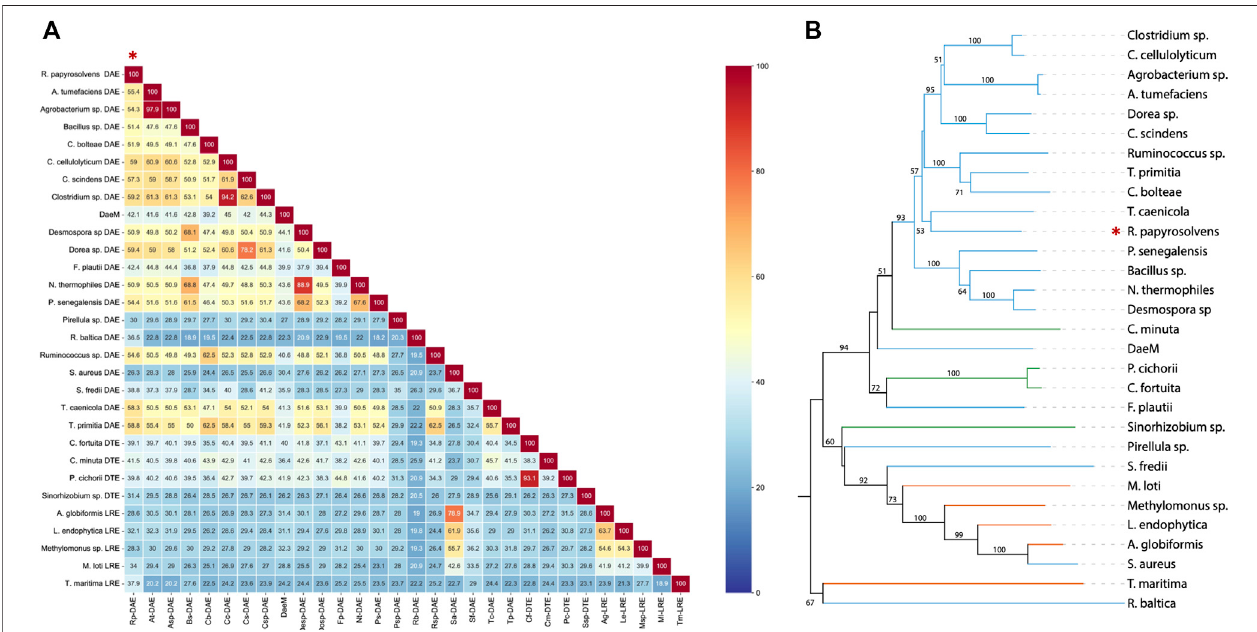
FIGURE 1 | (A) Sequence homology analysis of reported KEases. (B) Phylogenetic relationships of reported KEases. Blue treetops on behalf of DAE; green treetops on behalf of DTE; orange treetops on behalf of LRE.